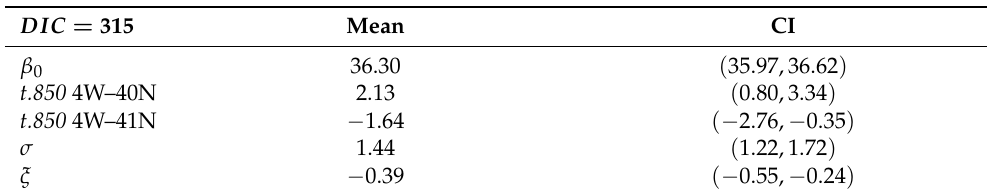
Table A3. Posterior mean and 95% CI of the final GEV model parameters according to the GEV-SSVS selection. Madrid (1920–2010).